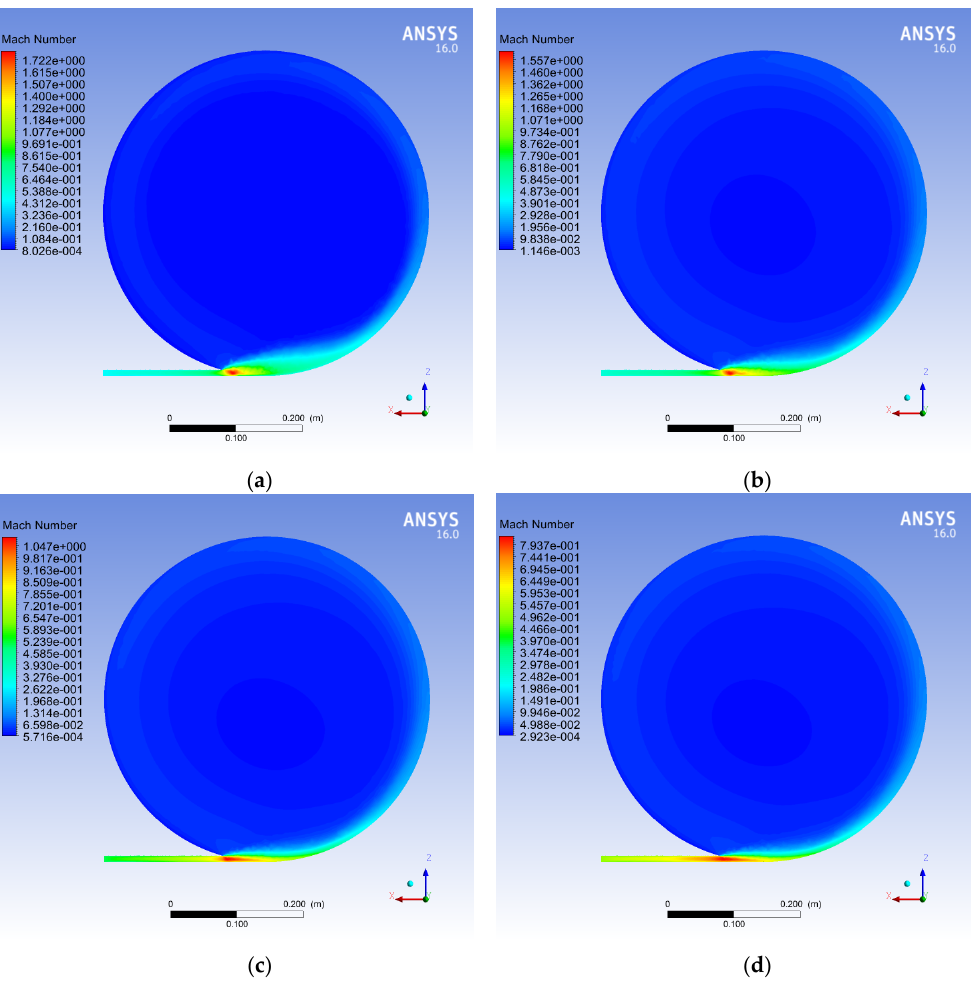
Figure 21. Mach number, F port, 27 L/min valve E ( a ) Mach number after 1 s. ( b ) Mach number after 3 s. ( c ) Mach number after 6 s. ( d ) Mach number after 9 s.